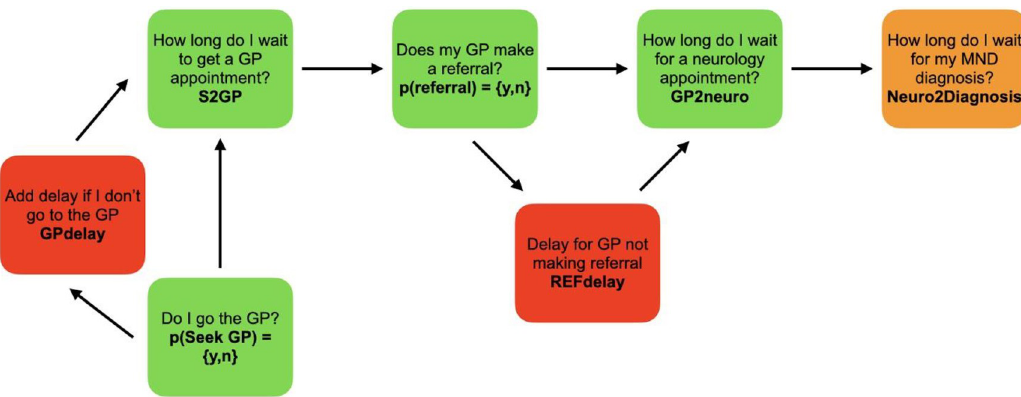
Fig 1. Nodes illustrating the typical MND diagnostic pathway used in this